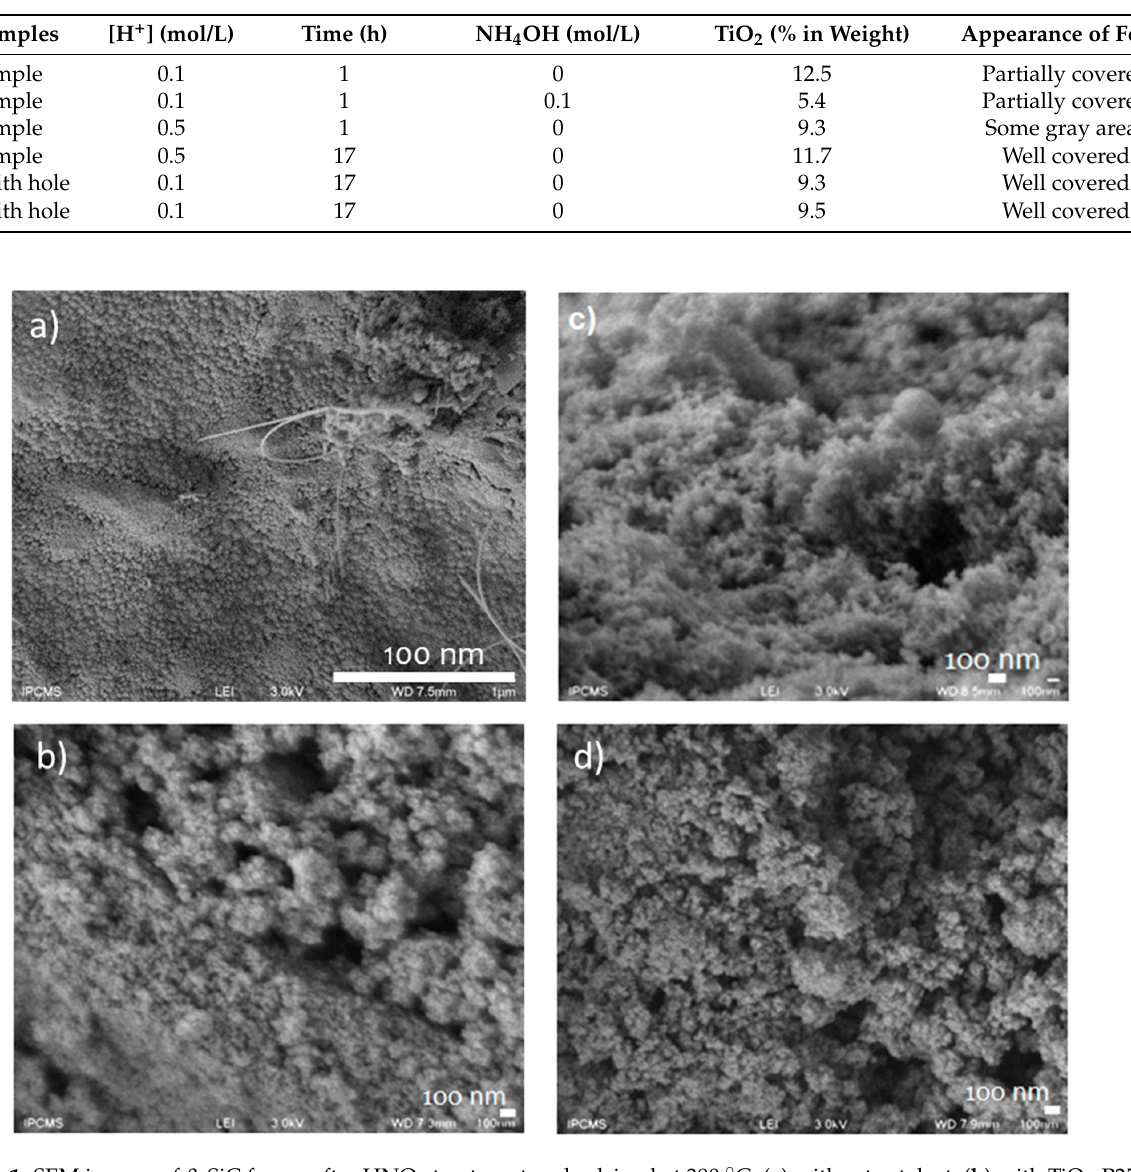
Table 2. Values of specific area and pores volume of β -SiC foams with or without catalyst com- pared to powder catalysts. Samples